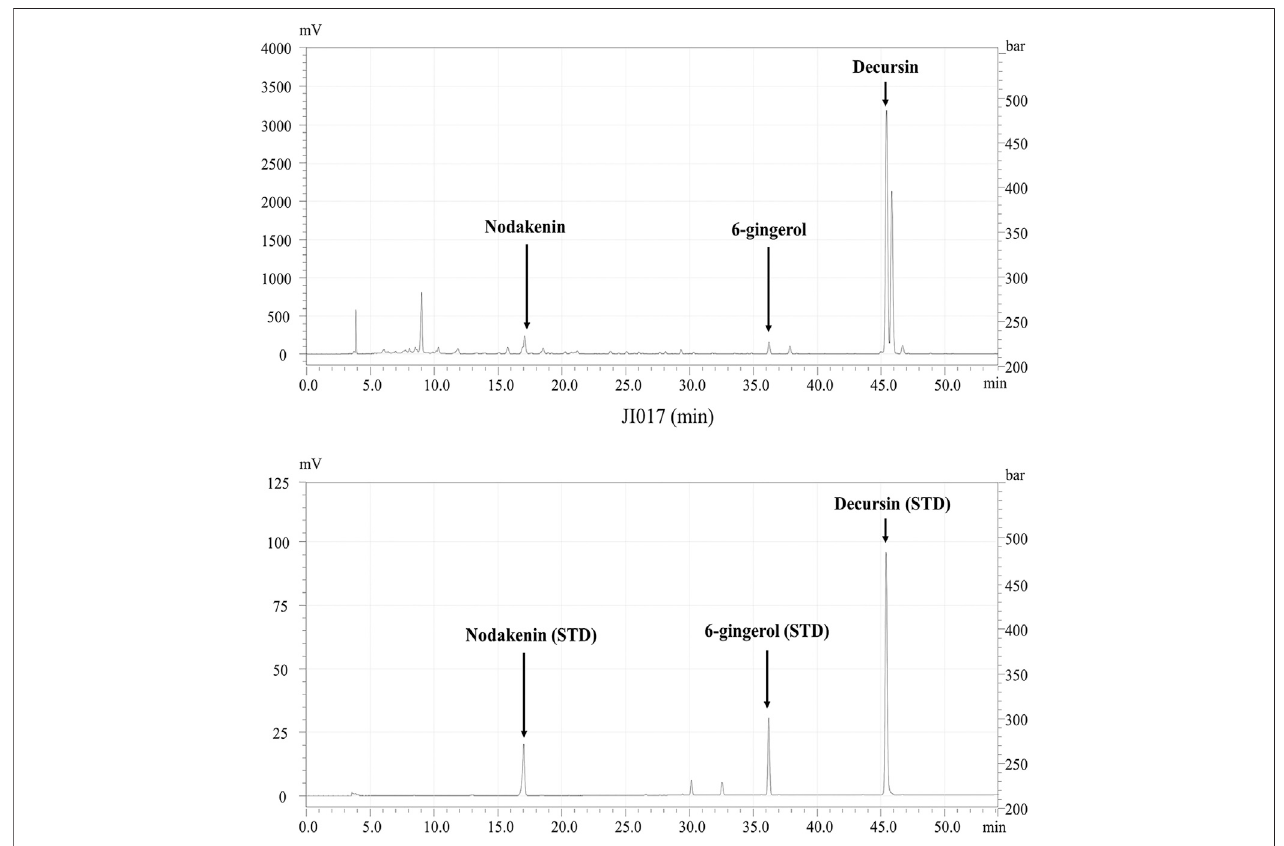
FIGURE 1 | HPLC pro fi le of JI017. Identi fi cation of the components in JI017; nodakenin, aconitine, 6-gingerol, and decursin were detected at 17, 33, 36, and 46 min,